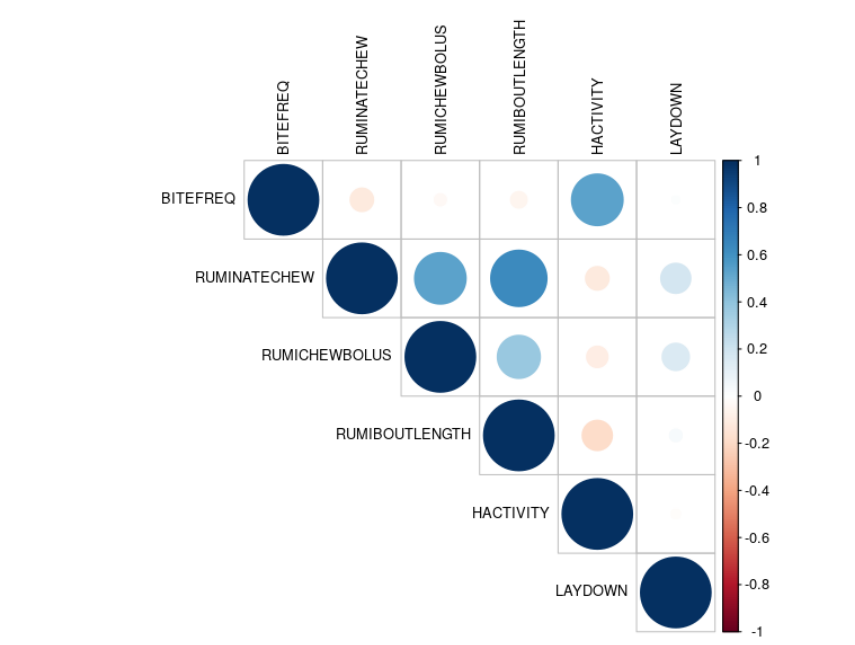
Figure 4. Pairwise correlations among the important predictors in the random forest model. Intensity of blue and red colour represents the strength of positive and negative correlation,